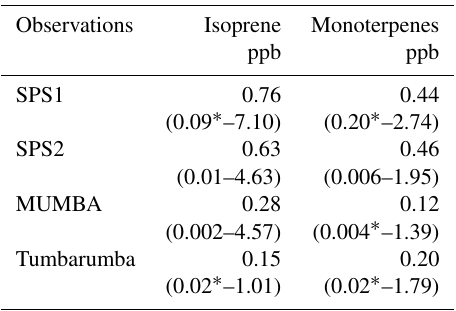
Figure 7. Campaign average diurnal cycles for isoprene (left), monoterpenes (middle) and the ratio of isoprene carbon to monoter- pene (MT) carbon (right). (a) SPS1, (b) SPS2, (c) MUMBA and (d) Tumbarumba. F2: percentage within a factor of 2 between ob- servations and base